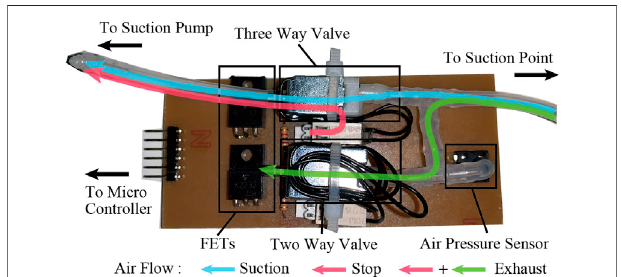
FIGURE1| Photoofthesuctioncontrolmodule.Theairpressuresensor measures the suction air pressure and the microcontroller switches the three- way solenoid valve and two-way solenoid valve with FETs. These are controlled by a microcontroller on the motherboard.